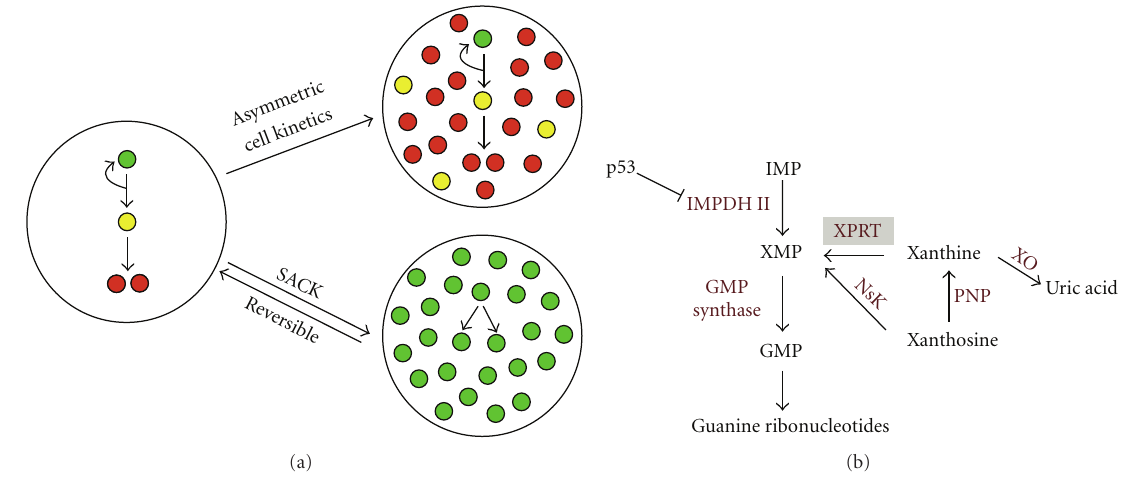
Figure 1: The SACK method for the expansion of tissue stem cells. (a) In vivo , tissue stem cells divide with asymmetric cell kinetics to produce progeny that eventually undergo a terminal cell cycle arrest and di ff erentiate. Asymmetric cell kinetics maintains an equilibrium between renewal of di ff erentiated tissue cells and preservation of constant tissue stem cell number. When tissue stem cells are cultured ex vivo , asymmetric cell kinetics results in their dilution and loss as a consequence of the accumulation of their di ff erentiating progeny cells. The SACK method shifts tissue stem cells to symmetric cell kinetics that reversibly promotes their exponential expansion. Green circles, tissue stem cells; yellow circles, transient-amplifying lineage-committed cells; red circles, terminally arrested di ff erentiated cells. (b) The guanine ribonucleotide biosynthesis pathway that controls tissue stem cells’ self-renewal pattern. The rate-limiting step for cellular guanine ribonucleotide biosynthesis is the formation of xanthosine-5 (cid:3) -monophosphate (XMP) from inosine-5 (cid:3) -monophosphate (IMP), the reaction catalyzed by inosine-5 (cid:3) -monophosphate dehydrogenase II (IMPDH II). The asymmetric cell kinetics of tissue stem cells requires downregulation of IMPDH II expression by the tumor suppressor protein p53. Supplementation with exogenous guanine ribonucleotide precursors, like xanthosine, which expands guanine ribonucleotide pools, converts tissue stem cells to symmetric cell kinetics despite normal p53 expression. Cells expressing a xanthine phosphoribosyl transferase (XPRT) transgene can use the highly membrane-permeable precursor xanthine to achieve symmetric cell kinetics. GMP, guanosine monophosphate; NsK, nucleoside kinase; PNP, purine nucleoside phosphorylase; XO, xanthine